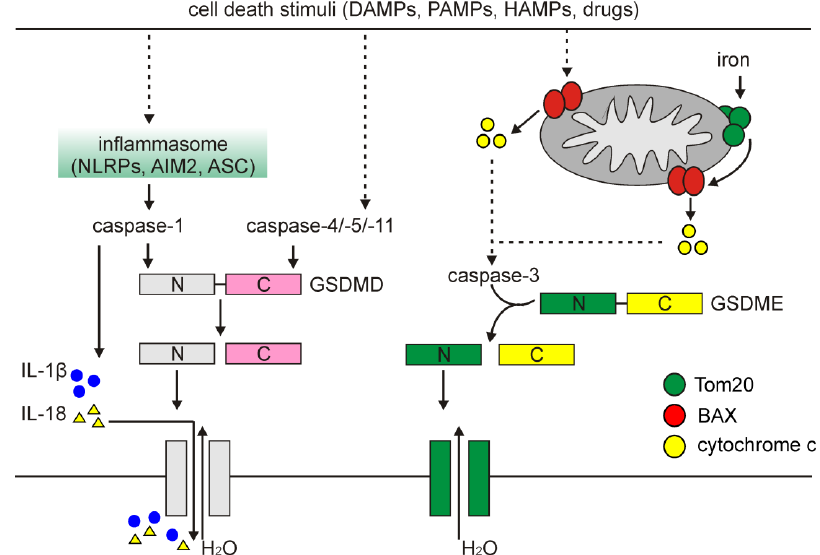
Figure 5. Signaling pathways that regulate pyroptosis. Pyroptosis-inducing stimuli